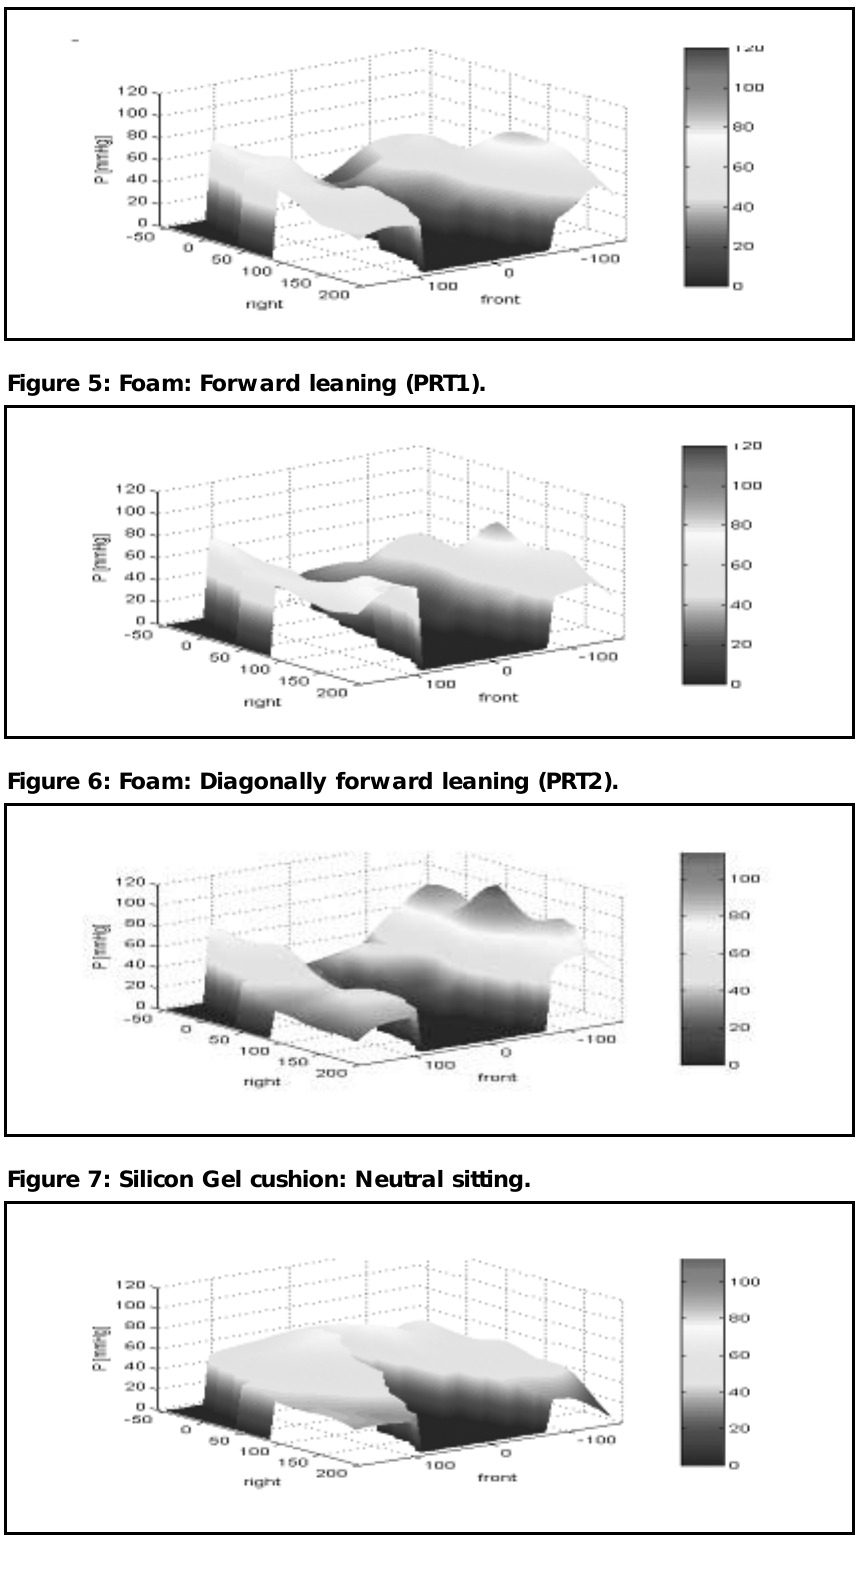
Figure 4: Foam: Neutral Sitting.